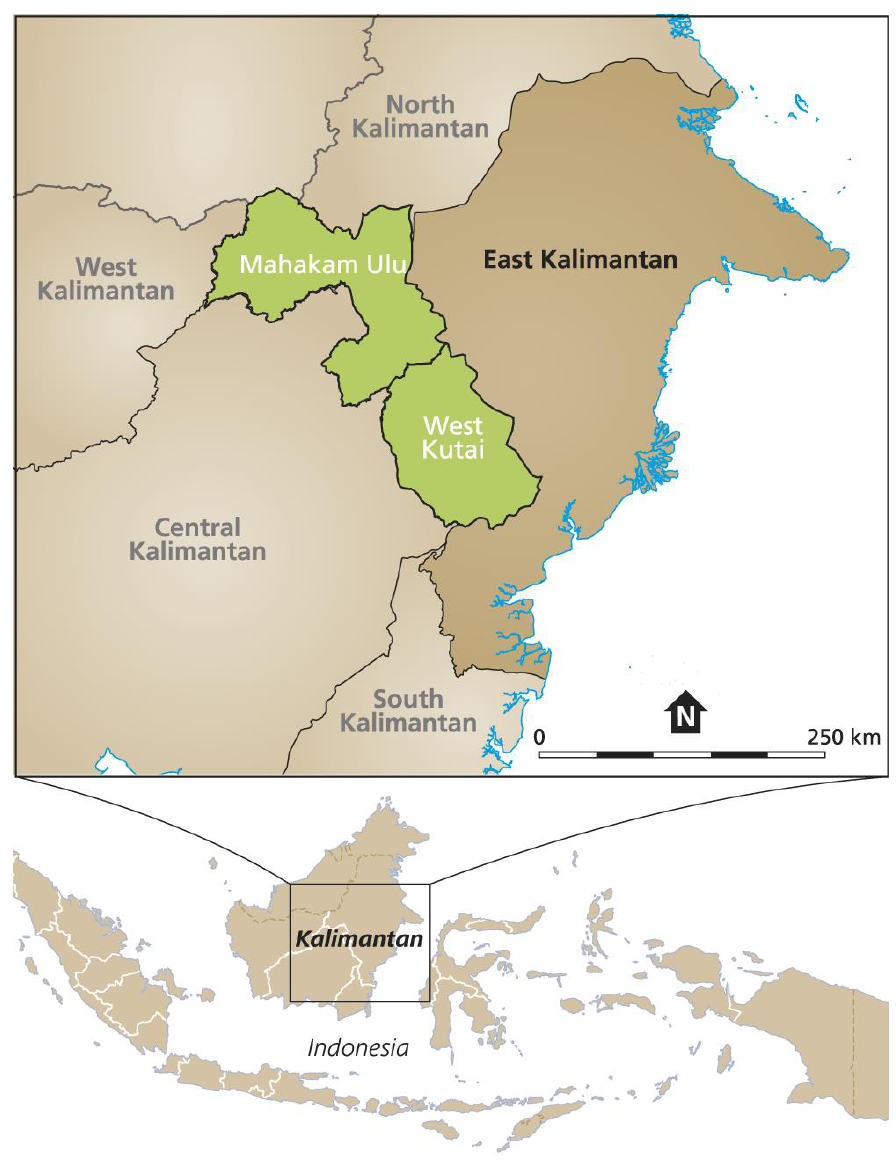
Figure 1. Map of the West Kutai and Mahakam Ulu districts, province of East Kalimantan, Indonesia.